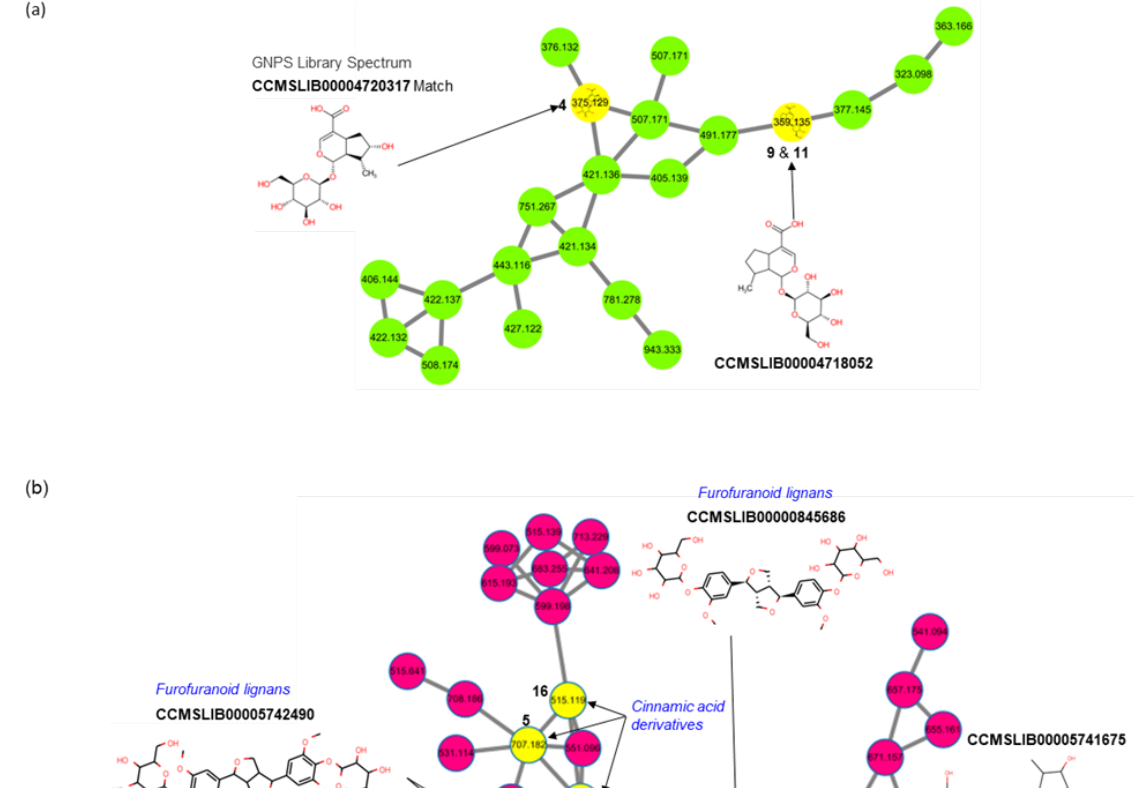
Figure 1. Proportion of serious/Grade Figure 7. Cont as monotherapies (drugs assessed in less than 20 patients or not reporting both serious/Grade AEs).